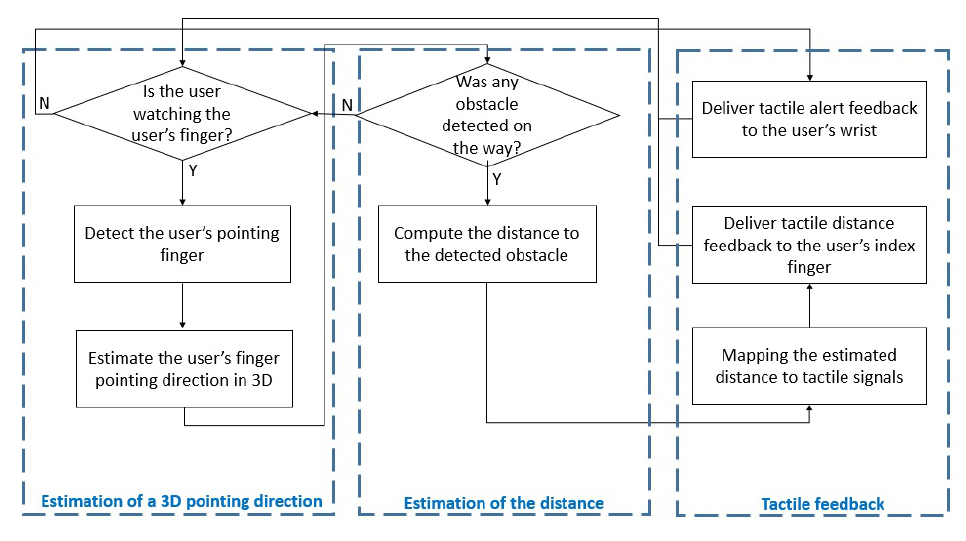
Figure 16. A flow chart of a complete solution of our proposed virtual cane system including a tactile feedback